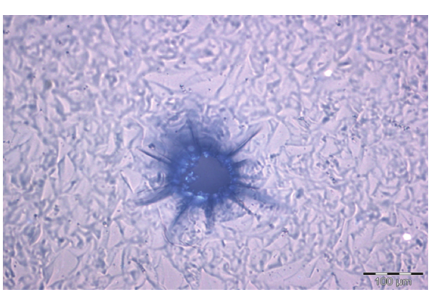
Figure 8: Hard particle or debris (metal) the bar is 0.1mm (CNES property).